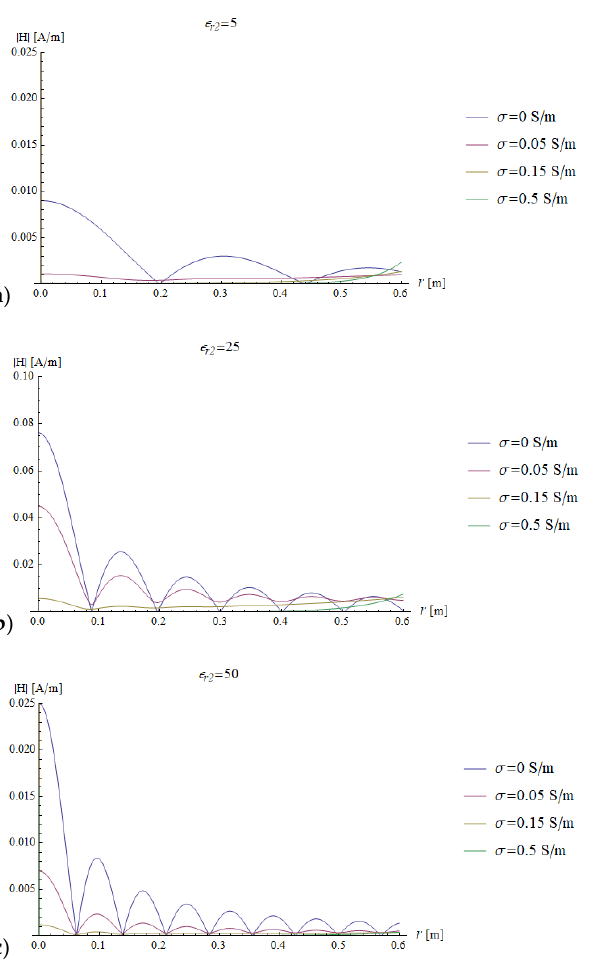
Figure 8. The amplitude of the magnetic field inside a sphere of radius a = 0.6 is plotted as a function of the radial coordinate r for different values of relative permittivity ( ε r 2 = 5, 25 and 50 in ( a – c ), respectively) and conductivity (see plot legend).